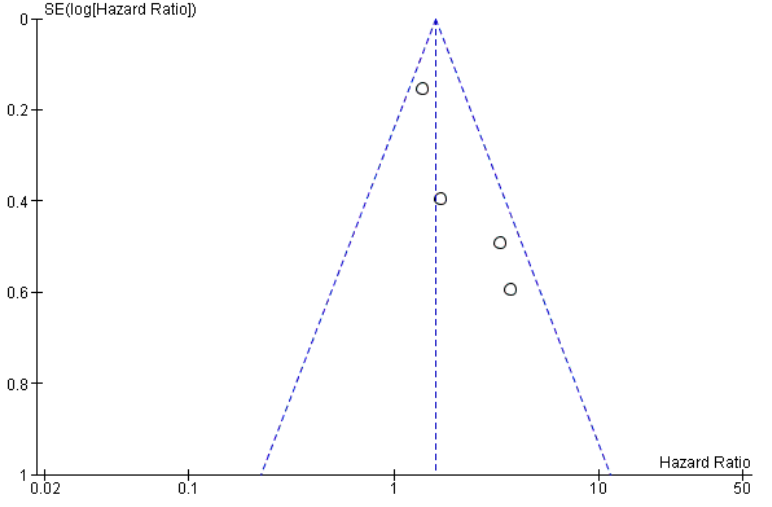
Figure 3. Funnel plot. The absence of heterogeneity is evident graphically. I 2 = 38%, SE: standard error. To reduce the weight of the study by Qiang et al. of 76.1% in the meta-analysis, it was decided to also apply a random-effects model. In fact, the weight of the study on the meta- analysis drops to 50% with an HR value of 1.86 [1.18, 2.93], always in favor of the worsening of OS (Figure 4). Figure 4. Forest plot of the random-effects model of the meta-analysis. 3.6. Trial Sequential Analysis, Grade Trial sequential analysis (TSA) was performed to evaluate the power of the meta- analysis, adjusting the results to avoid type I and II errors. The program used was Stata 13 (StataCorp, College Station, TX, USA), with the integration of the R 4.2 software (Foundation for Statistical Computing, Vienna, Austria) through the Metacumbounds commands, as described by Miladinovic et al. [38]. The O’Brien—Fleming spending function was used by applying random effects. The accrued information size (AIS) and, subsequently, a priori information size (APIS) commands were used by the Dialog BOX to determine the optimal sample size and assuming a reduction risk relative (RRR) of 38%, an Alpha value equal to 5% (type 1 error), and beta at 20% (type 2 error) (Figure 5) for the power of the results.